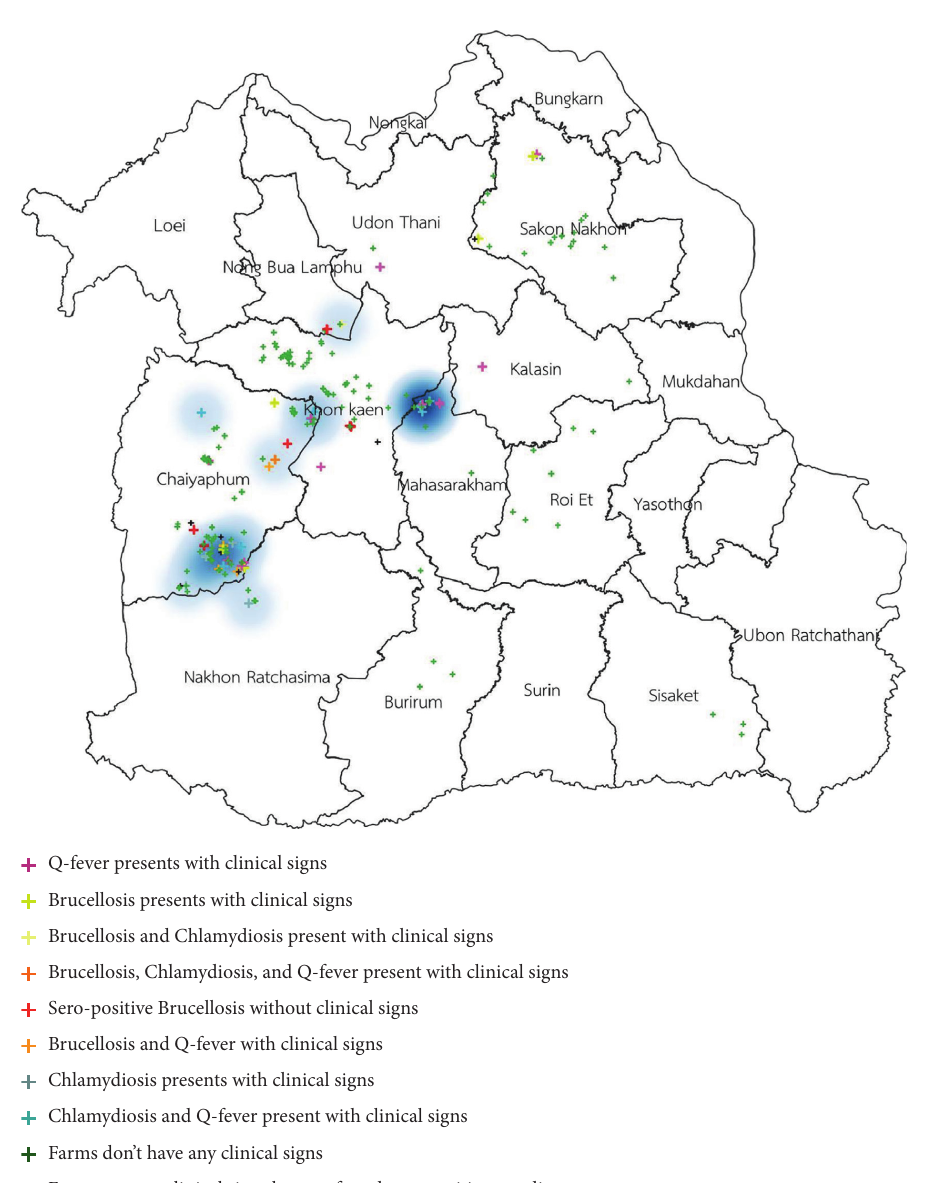
Figure 3: Distribution of clinical cases of chlamydiosis infection in smallholder meat goat herds in northeastern